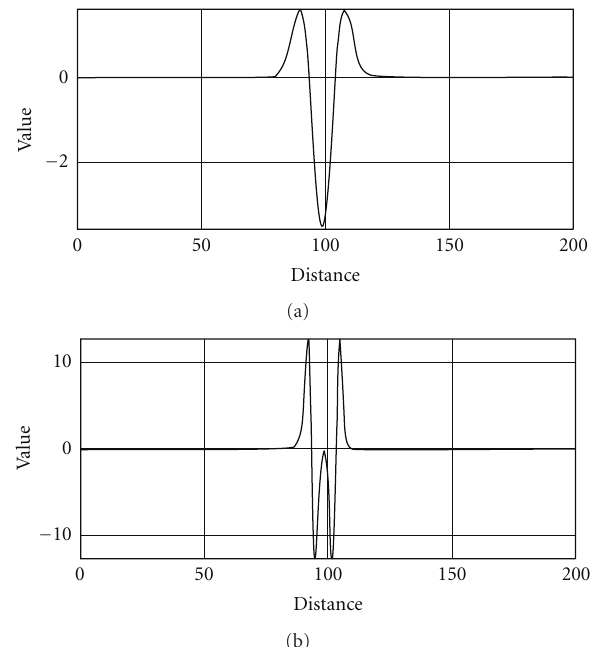
Figure 6: Intensity profiles of responses to Gaussian (a) and bar-like (b) ridge models.